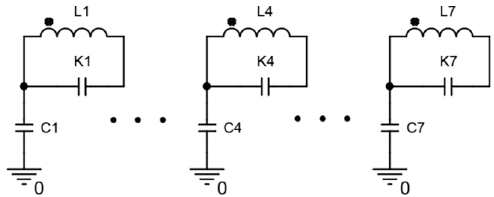
Figure 3. Transformer lumped parameter model.